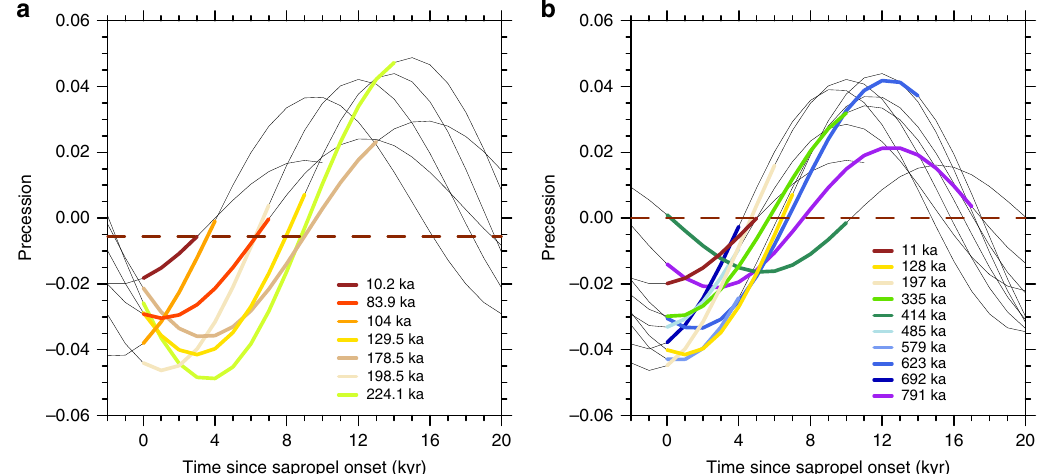
Fig. 3 The relationship between sapropel formation and orbital precession using two sapropel chronologies. Precessional curves associated with sapropel formation are aligned to the start of each occurrence according to the respective chronology. The coloured segments of these curves indicate the actual duration of the sapropel. The red horizontal line indicates the precession at the termination of the most recent sapropel. a A speleothem-tuned chronology 24 provides well-constrained estimates of the onset and termination of sapropels over the past 250,000 years. b The past ten